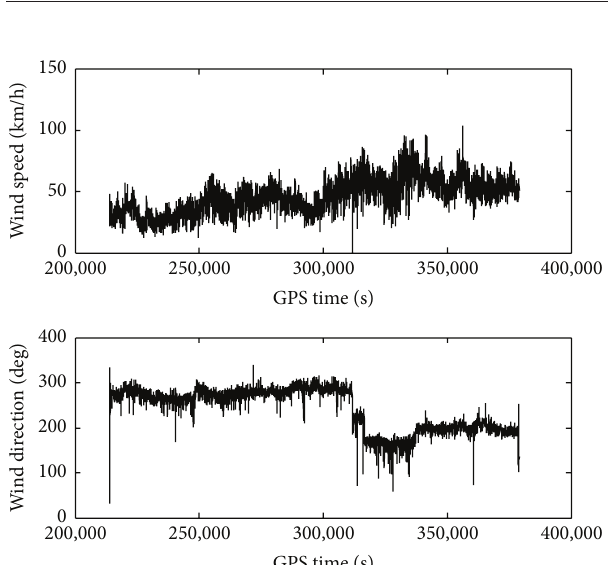
Figure 11: The wind speed and direction during the observation